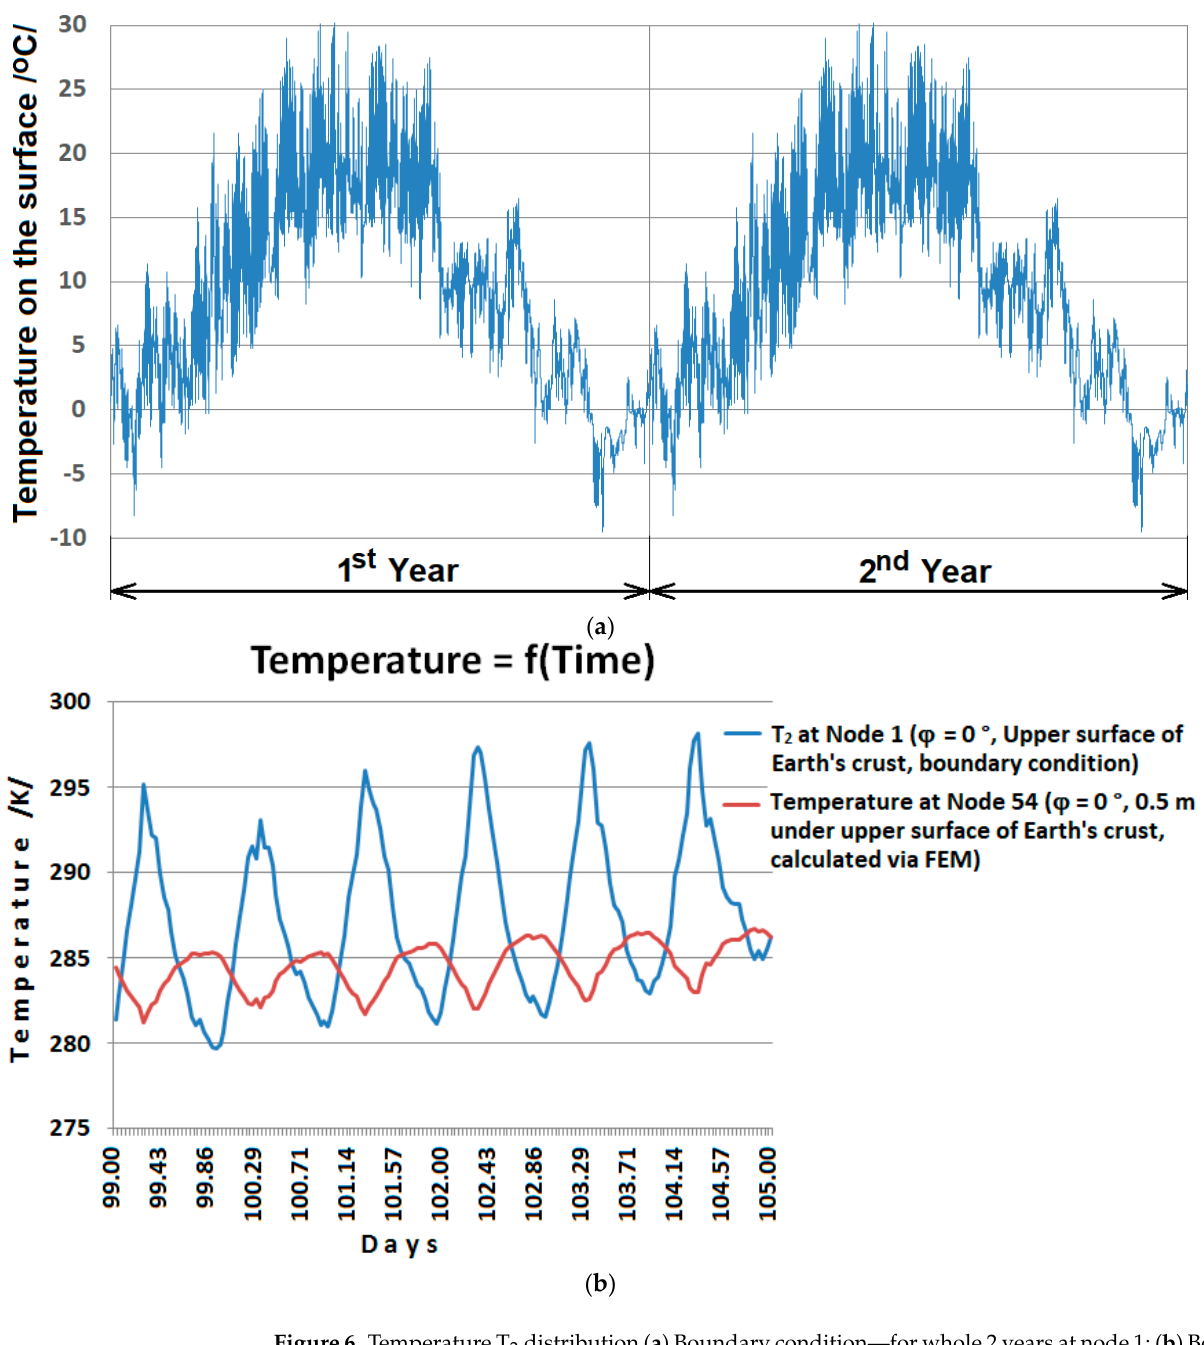
Figure 6. Temperature T 2 distribution ( a ) Boundary condition—for whole 2 years at node 1; ( b ) Boundary condition at node 1 and calculated temperature at node 54 for 99th to 105th day of solution.